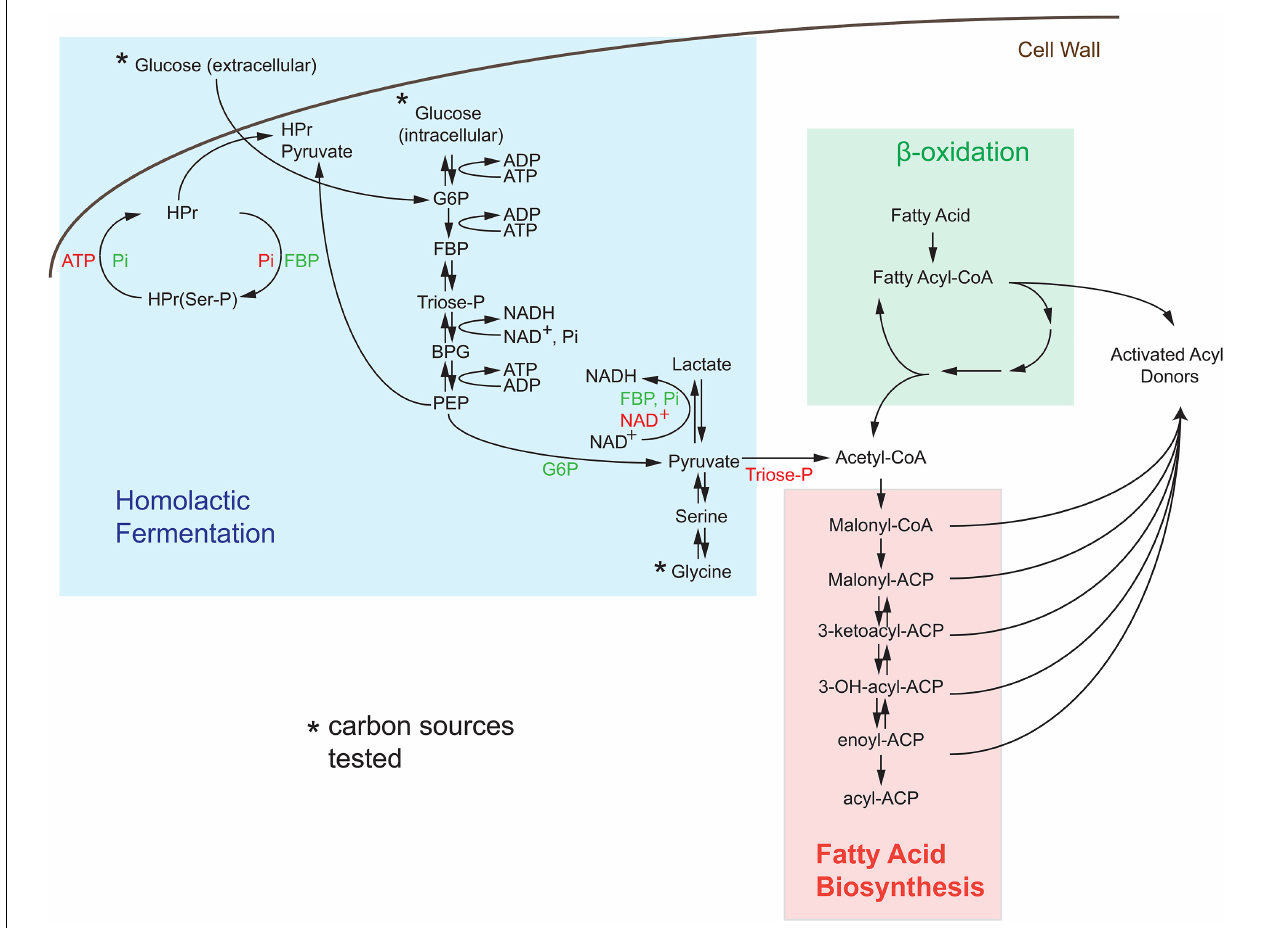
FIGURE 3 | De novo synthesis of acyl donors via central carbon metabolism in Streptococcus . Activated acyl donors, the substrates for the luxABCDE machinery, are made by the breakdown of fatty acids through β -oxidation (denoted as green region) or by the synthesis of an activated carrier protein (ACP)-containing metabolites via fatty acid biosynthesis (denoted as salmon region). Since S. pyogenes lacks the β -oxidation pathway, all substrates for light production in Strep . Xen20 are created by acetyl-coenzyme A (CoA)-dependent fatty acid biosynthesis generated by homolactic fermentation (denoted as blue box). The asterisk indicates the sole carbon sources tested. Allosteric activators, such as inorganic phosphate (Pi), fructose bisphosphate (FBP), and glucose-6-phosphate (G6P) are shown in green text, and allosteric inhibitors, including adenosine triphosphate (ATP), nicotinamide adenine dinucleotide (NAD +), and triose phosphate (triose-P), are shown in red text. Abbreviations used in here is as follows: histidine-containing carrier protein (HPr), phosphorylated HPr [HPr(Ser-P)], phosphoenolpyruvate (PEP), and 1,3-bisphosphoglyceric acid